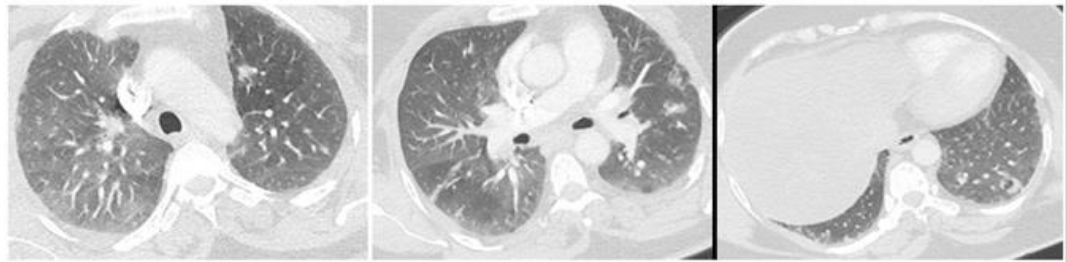
Figure 1. The chest CT scan performed three weeks after the onset of the respiratory sign joint signs, shows some pulmonary